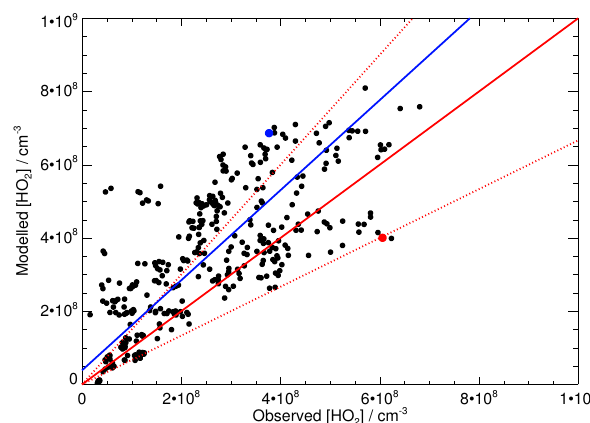
Fig. 2. (a) Observed ethane concentrations as a function of CO, r 2 = 0 . 737 and (b) observed iso -butane concentrations as a function of CO, r 2 = 0 . 268. The best fit lines are given in blue. Fig. 4. Comparison between modelled and observed HO 2 concentrations. The 1:1 line is shown by the solid red line, with dashed red lines indicating 50% limits on the 1:1 line. The best fit to the data is given in blue and is described by y =(1 . 23 ± 0 . 11) x +(3 . 85 ± 3 . 06) × 10 7 , with r 2 =0 . 75 . The data point in red marks the single point referred to in Sect. 4.2.1 for which the sensitivity to isoprene and NO x was investigated and used to represent the midday forest boundary layer referred to in Sect. 4.3 and Fig. 7. The data point in blue marks the single point used to represent the midday Sahel boundary layer referred to in Sect. 4.3 and Fig. 10.